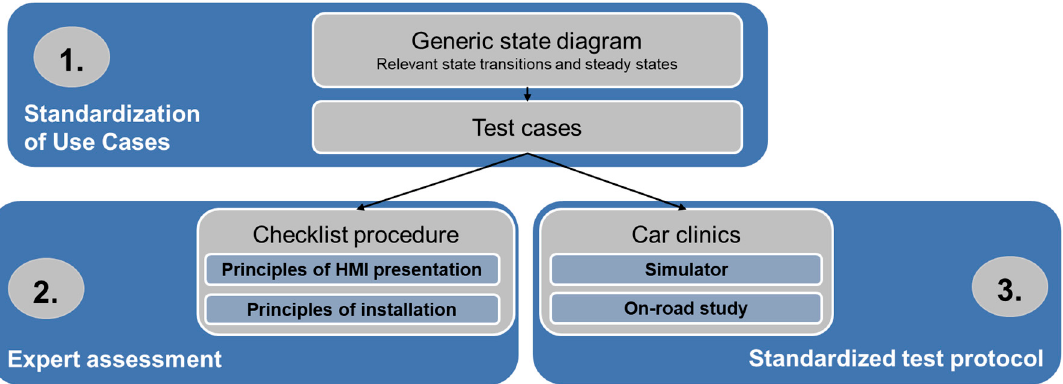
Figure 1. Overview of the test procedure for the evaluation of automated driving system (ADS) human–machine interfaces (HMIs) based on U.S. National Highway Traffic Safety Administration (NHTSA) requirements.